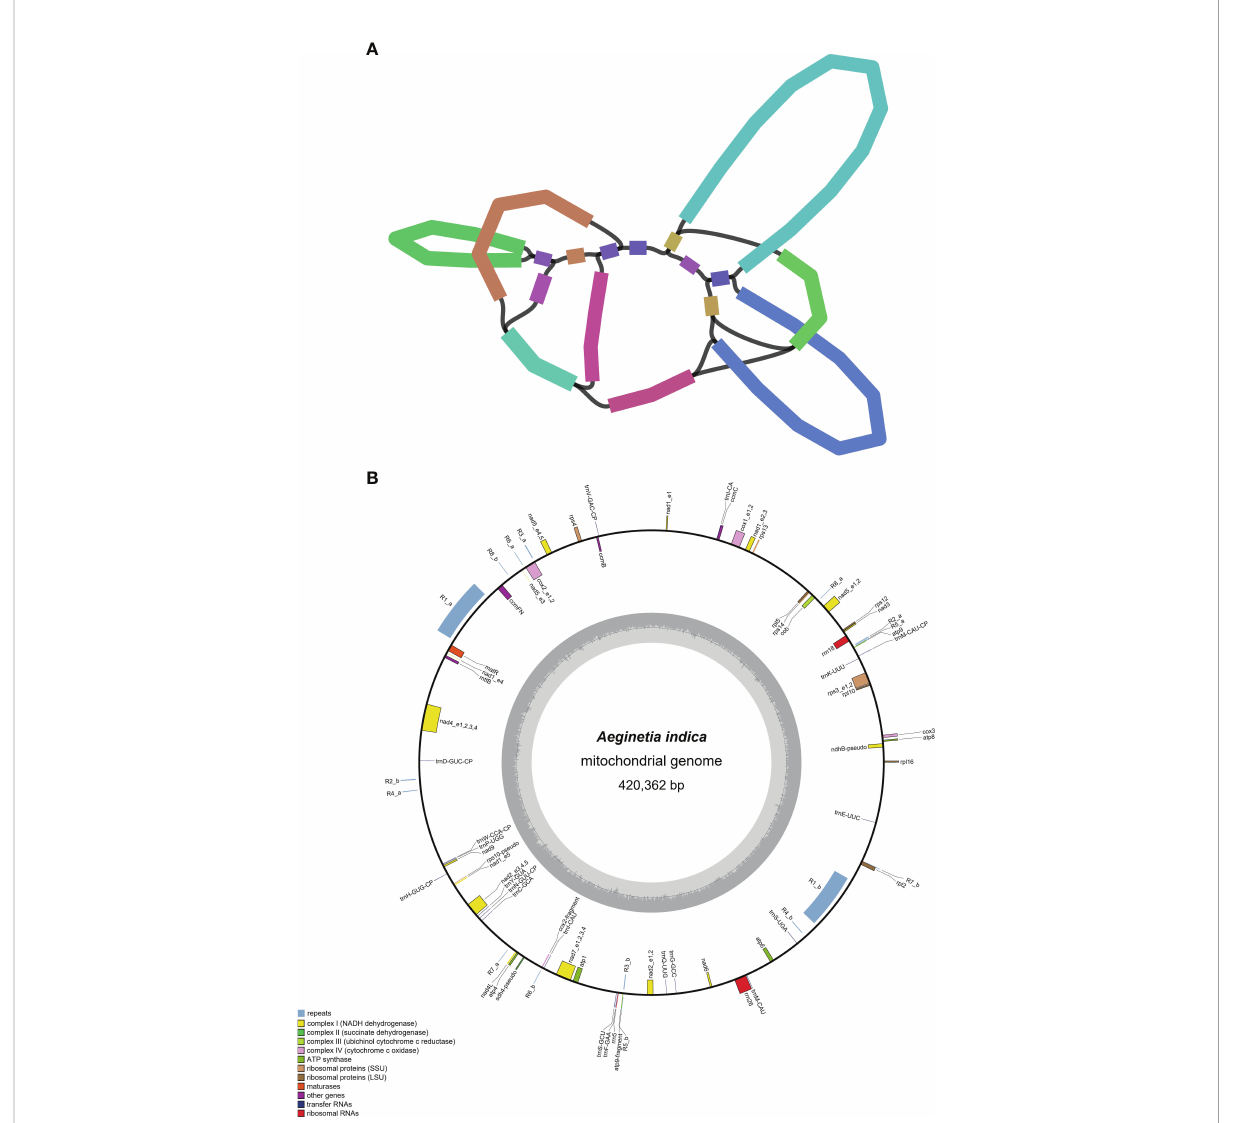
FIGURE 1 The mitogenome of Aeginetia indica . (A) , A network of the mitochondrial contigs of Aeginetia indica visualized in Bandage. (B) , Gene map. Genes shown outside the outer circle are transcribed counterclockwise, whereas those inside the outer circle are transcribed clockwise. The darker and light shading inside the inner circle indicates GC and AT content, respectively. The eight largest repeats (R1-R8) are also shown in blue in this fi